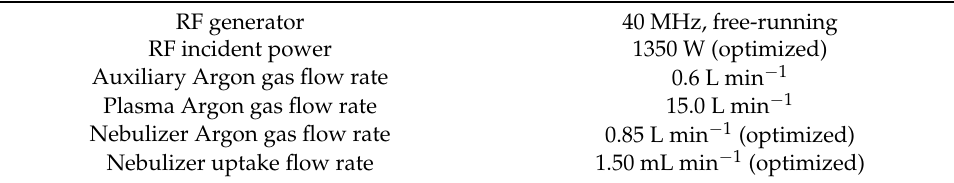
Table 1. Instrumental conditions and description of the ICP-AES system. RF generator 40 MHz, free-running RF incident power 1350 W